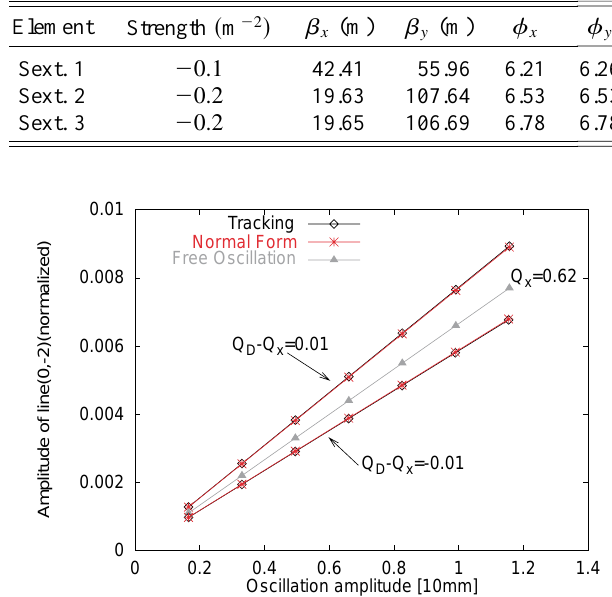
FIG. 2. (Color) Comparison of the normalized amplitude of the line 2 2 Q D from the horizontal motion of simulated tracking and the approximated model for the two different excitation frequencies Q D (cid:1) Q x 6 0.01 . The normalized amplitude of the line 2 2 Q x in the free oscillation case is also shown. These lines are due to the resonance term h 3000